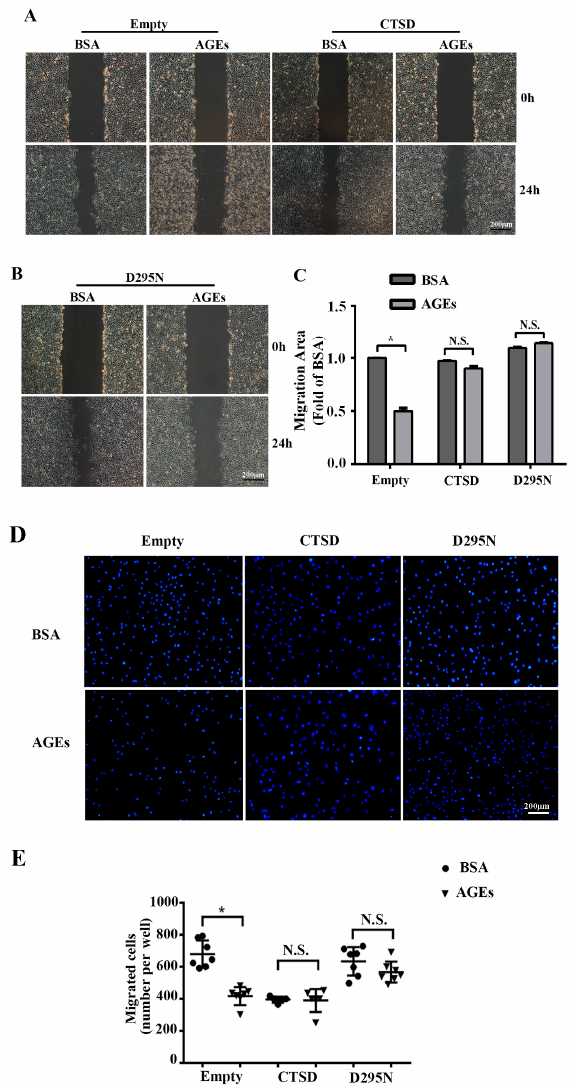
Figure 6. The effects of CTSD on the migration of HUVECs. Lentiviral plasmids containing wild-type CTSD or D295N CTSD cDNA were transduced into cells, which were classified into the CTSD group and D295N group, respectively. Cells with empty vector served as control. Cells were treated with 100 µg/mL AGEs or 10 µg/mL BSA as control, and incubated with serum-free DMEM for 24 h to inhibit cell proliferation. ( A , B ) Cell migration was analyzed by wound-healing assay; ( C ) The migration area was quantified by Image J 1.47, normalized by BSA group (* p < 0.05 vs. BSA + empty group. N.S., no statistical significance.). Three microscopic fields were randomly selected; ( D ) Cell migration was also analyzed by Hoechst 33342 staining in the transwell assay. Blue dots represented nuclei. Three microscopic fields were randomly selected; ( E ) Migrating cells were counted under microscopy (* p < 0.05 vs. BSA + empty group. N.S., no statistical significance.). All data were obtained from reproducible experiments ( n = 3).